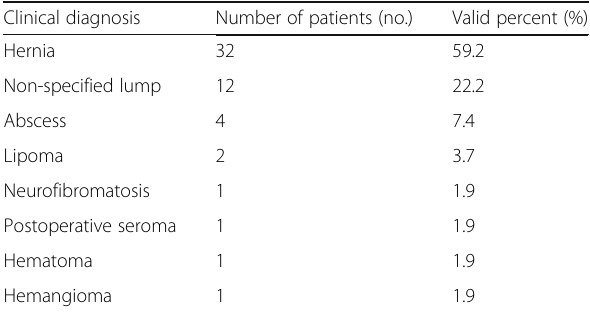
Table 2 The clinical diagnosis of the abdominal wall masses and the mass-like lesions with the demonstration of the number (no.) and the percent (%) of the affected patients Clinical diagnosis Number of patients (no.)